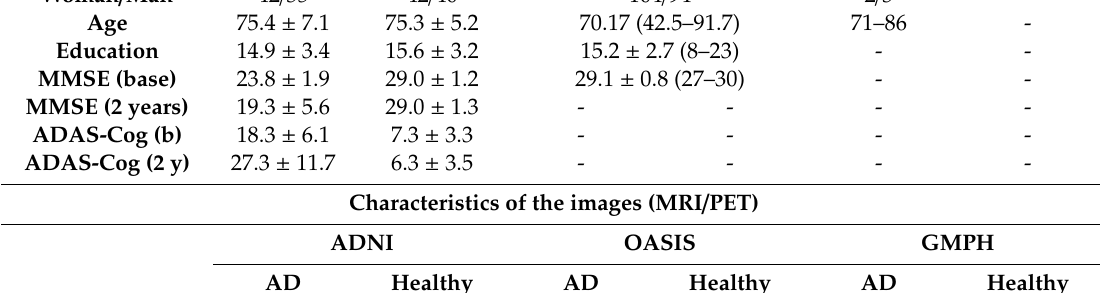
Table 1. Demographic information of the participants and the characteristics of the magnetic resonance imaging (MRI) and positron emission tomography (PET) images. Characteristics of Patients ADNI [60] OASIS [61] GMPH AD Healthy AD Healthy